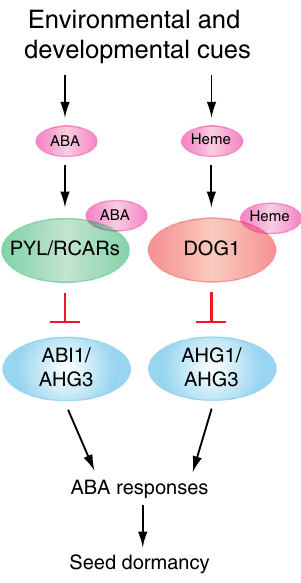
Fig. 9 A hypothesized regulatory system of seed dormancy. See the text for